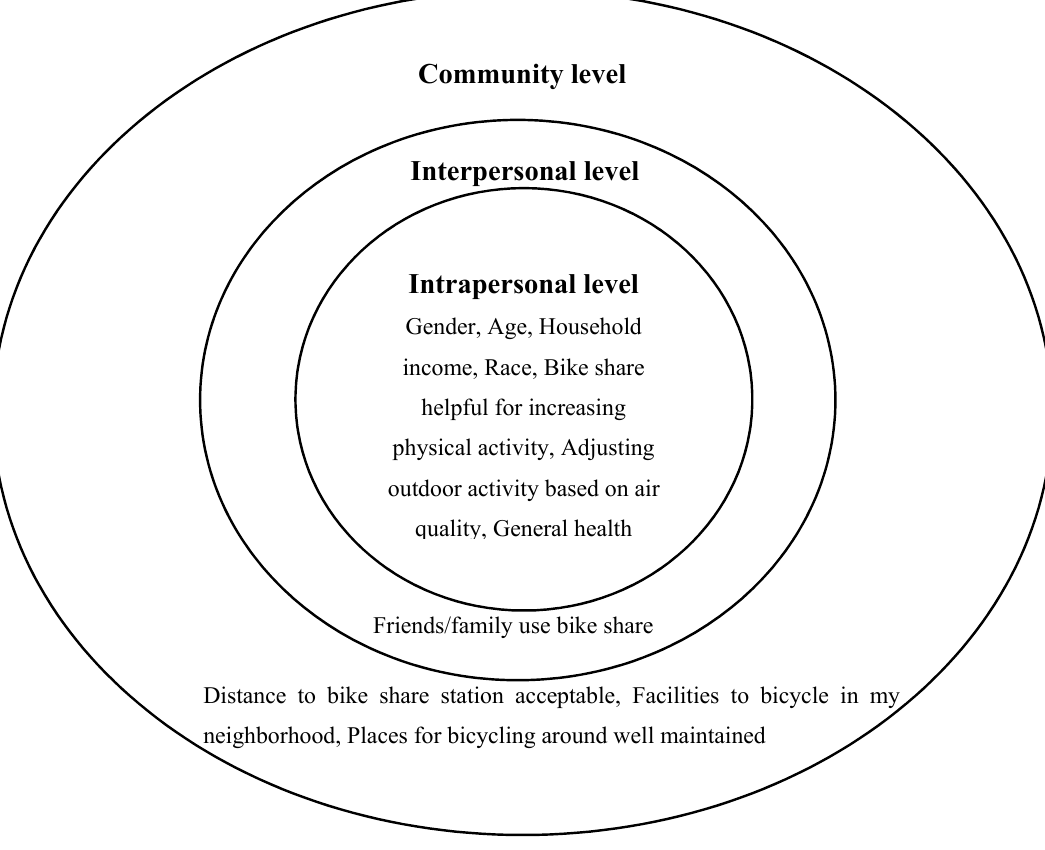
Figure 2. Socio-ecological predictors of frequent bike share trips; Bold fonts indicate the three levels of the socio-ecological model examined in this study.